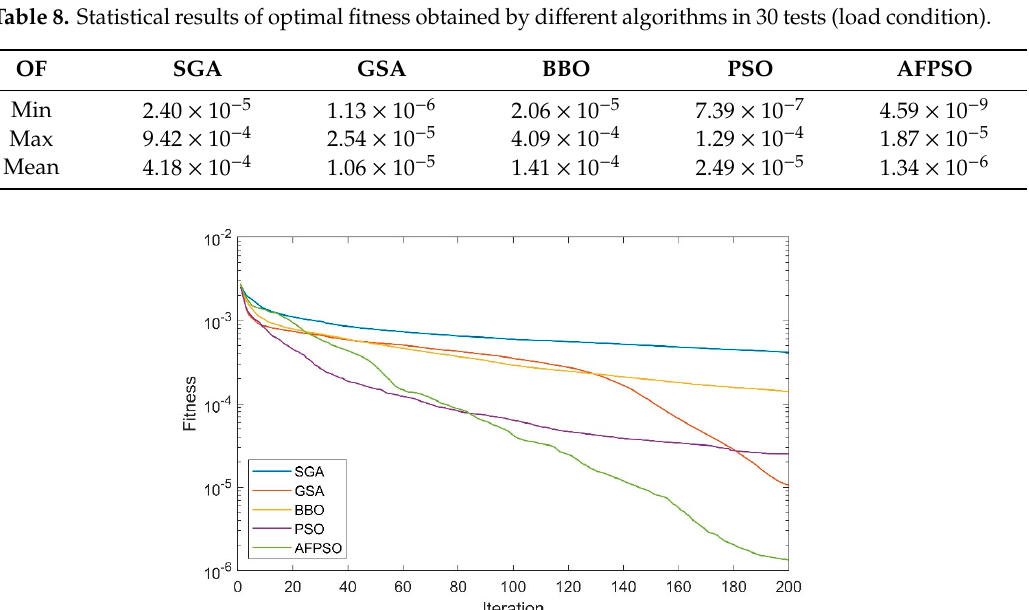
Table 6. Actual value and initial range of the parameters to be identified (load condition).